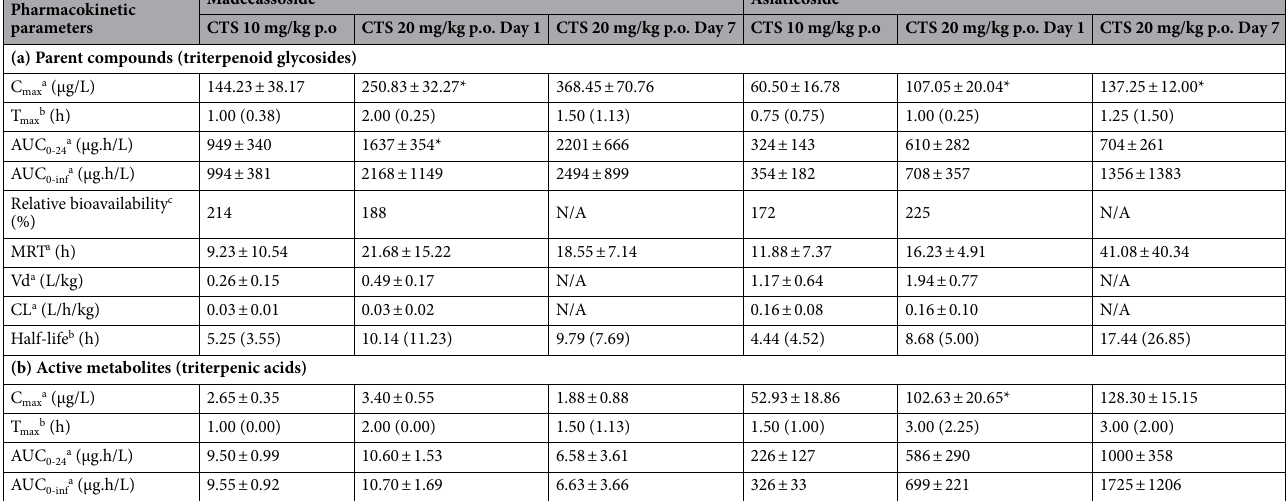
Table 2. Pharmacokinetic parameters of madecassoside and asiaticoside (a) and madecassic acid and asiatic acid (b) after oral administration of 10 and 20 mg/kg Centell-S as a single dose or repeated doses. C max